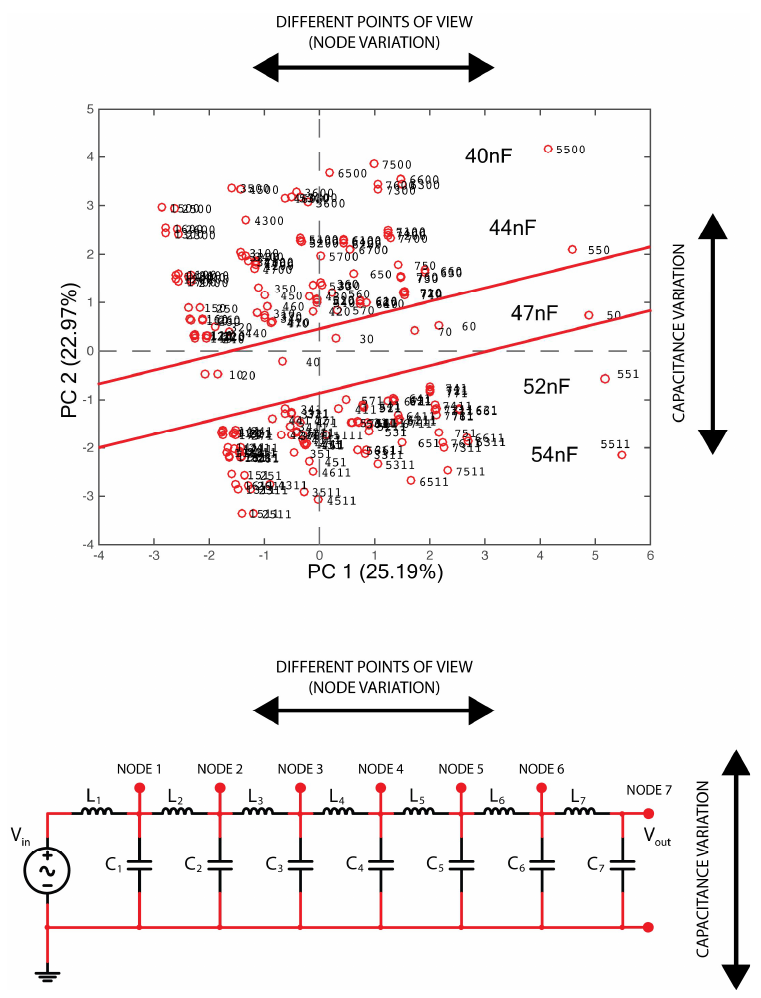
Figure 12. Representation of the localization action, which can be performed using the PCA model of Figure 11 in finding out the variation that occurred.